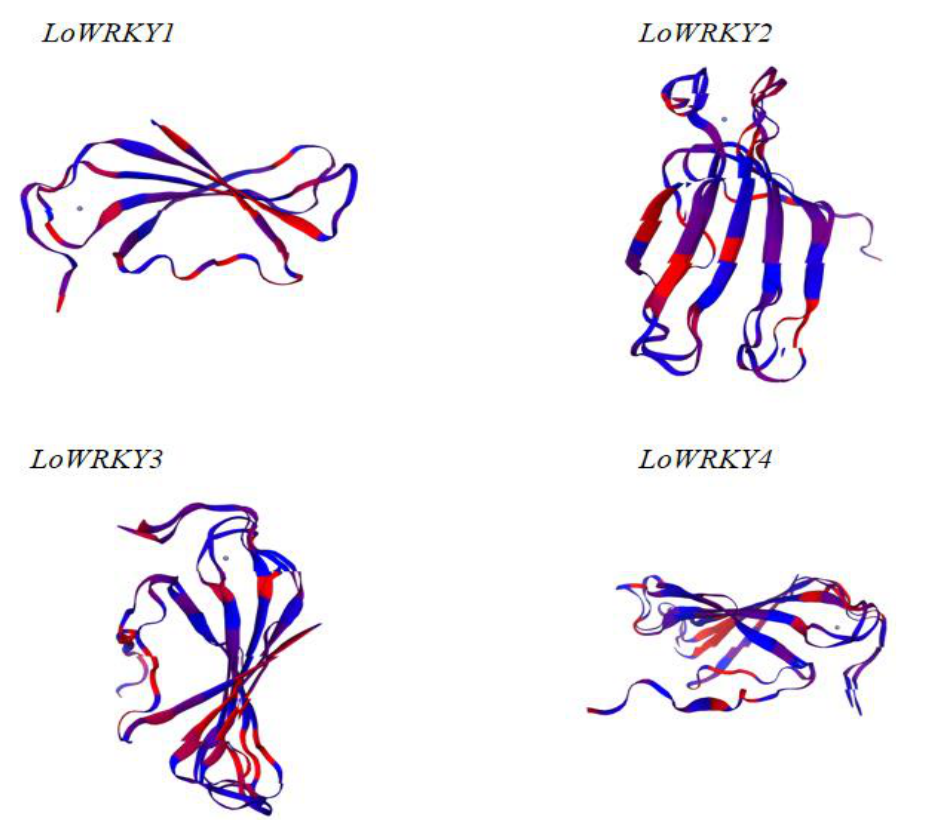
Figure 4. Predicted LoWRKY transcription factor family gene protein tertiary structure. Red: alpha helix, blue: random coil, white: beta turn.